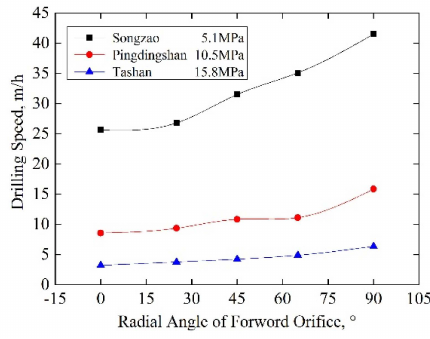
Figure 8. Graph showing the relationship between self-drilling speed and forward orifice radial angle. Strength of coal samples: 5.1, 10.5 and 15.8 MPa.